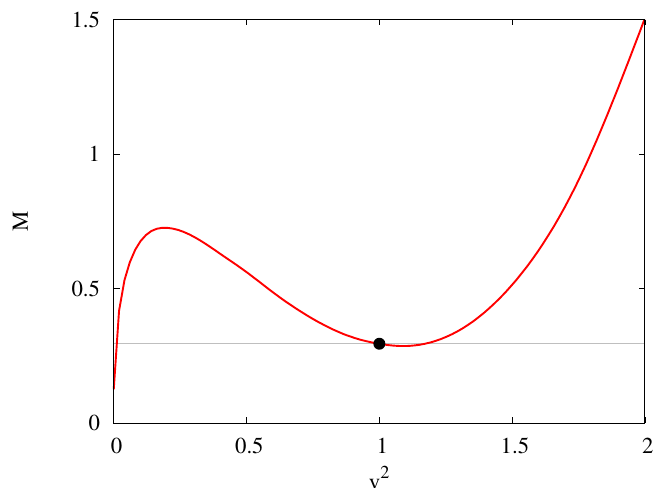
Figure 9. Mass M is shown vs: the deformation parameter v 2 for the squashed backgrounds (vacuum static spacetimes). The horizontal line and the dot mark the v = 1 mass, corresponding to the Casimir value 3 (cid:25)L 2 = 32, with L =